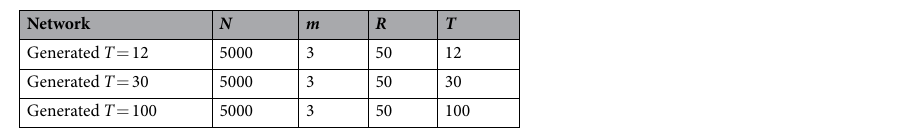
(diameter, degree distribution and clustering) intact. The applied geometric representation of networks is an active and quickly advancing research direction in network science 18 . There are numerous studies describing networks as random geometric graphs, performing some functions 19, 20 (e.g. navigation, information transmis- sion) or structural properties (e.g. small-world, clustering, modularity) 21, 22 of networks in a geometric context, and disclosing some fundamental relations between topology and hidden metric spaces 23 . A the proper choice of